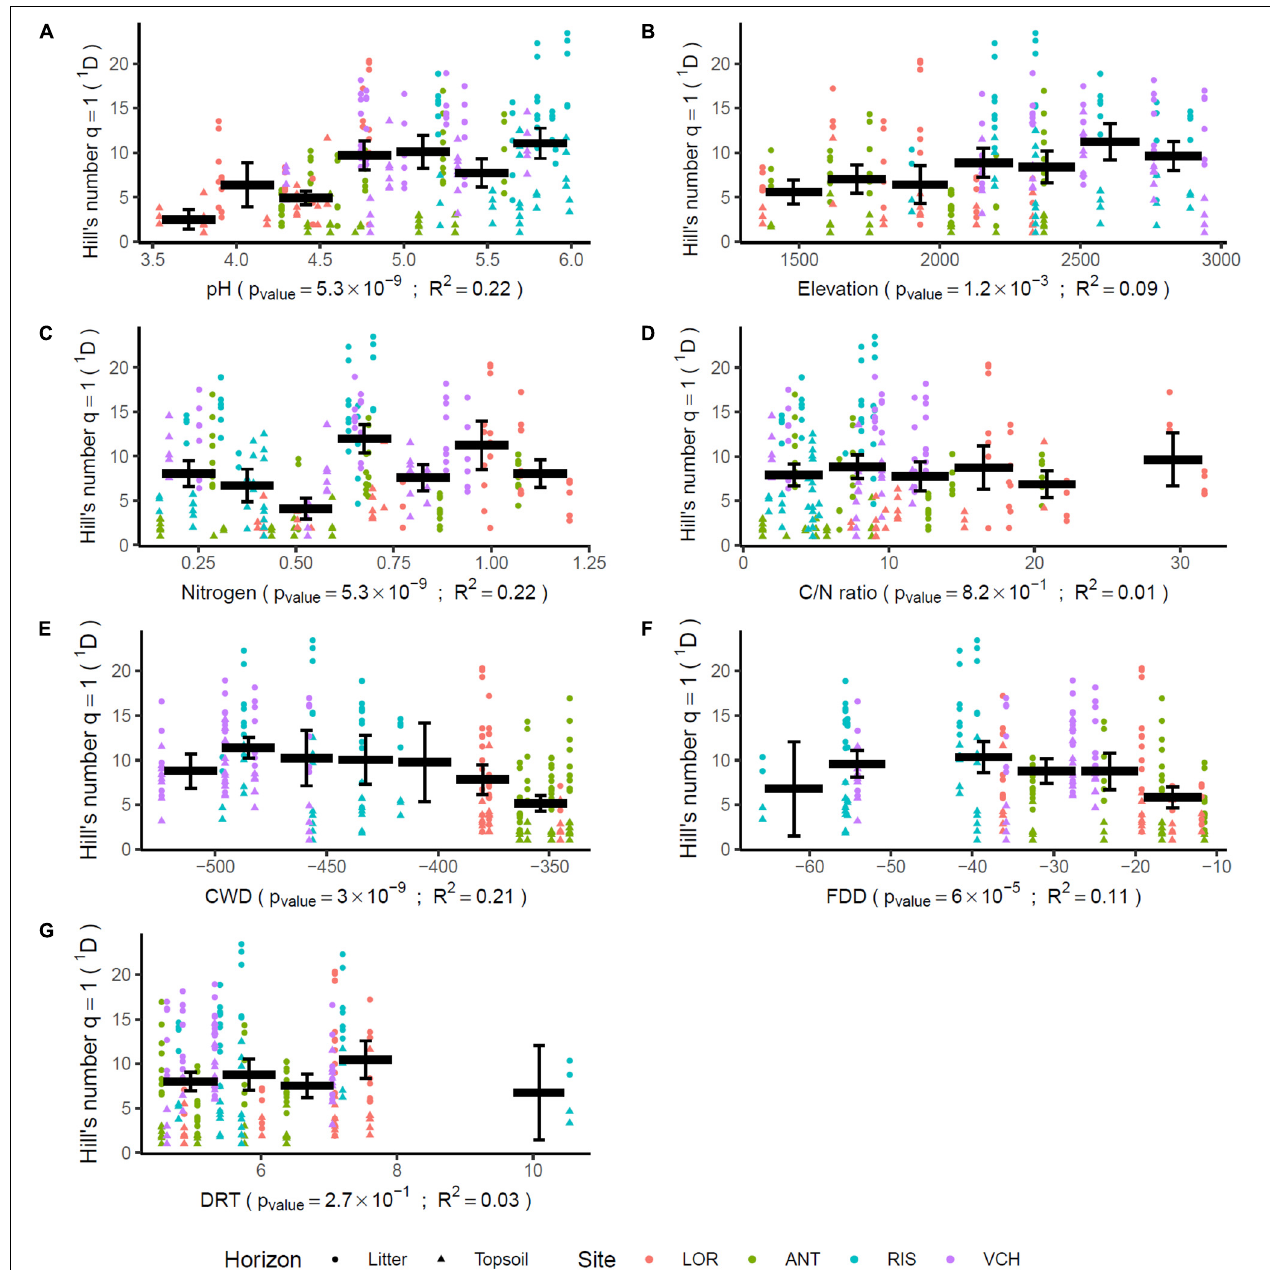
FIGURE 5 | Impact of environmental parameters on algae community diversity. Each gradient is divided in seven parts. This division allows for mixing in a single part, samples from several sites. The bold horizontal bars indicate the mean of the diversity for the covered interval. The whiskers delimitate the 95% confidence interval of that mean. The p -values are adjusted for multiple tests using the false discovery rate method (Benjamini and Hochberg, 1995). The determination coefficients R 2 measure the part of the variance explained by the sliced gradients using one way ANOVA.